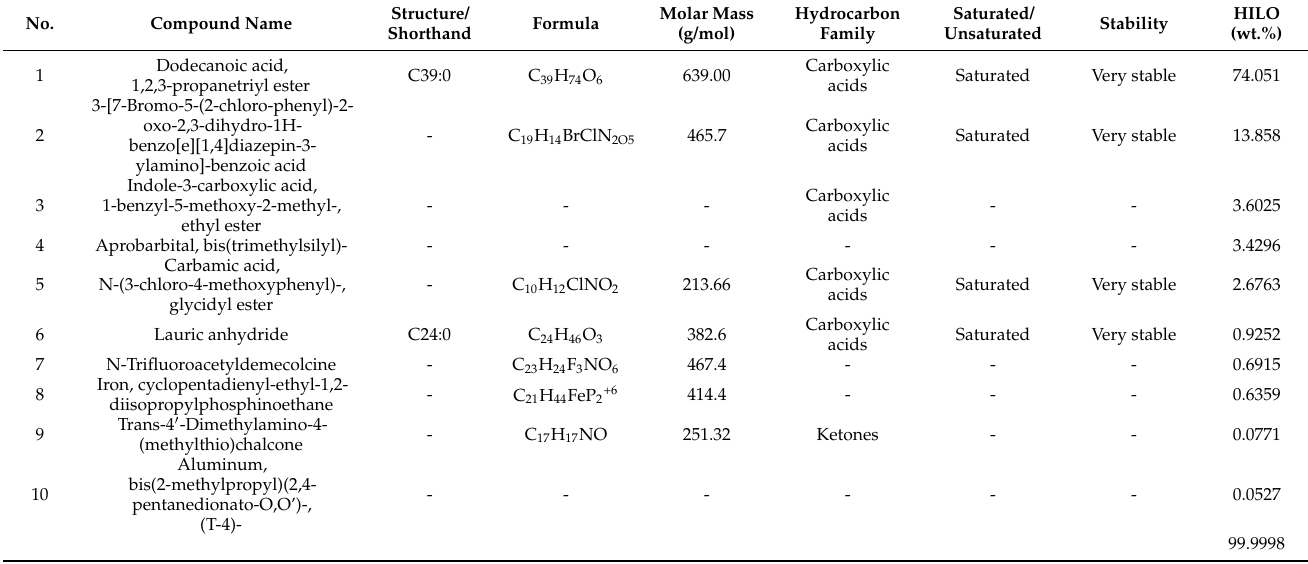
Table A2. Chemical composition of